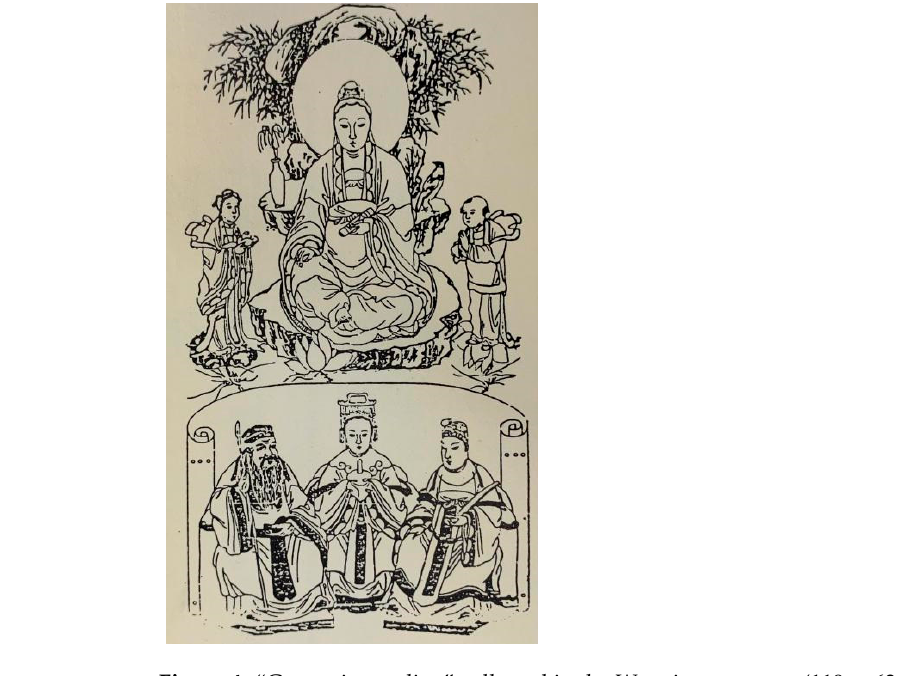
Figure 4. “Guan-yin-ma-lian” collected in the Wenying museum (119 × 63 cm).